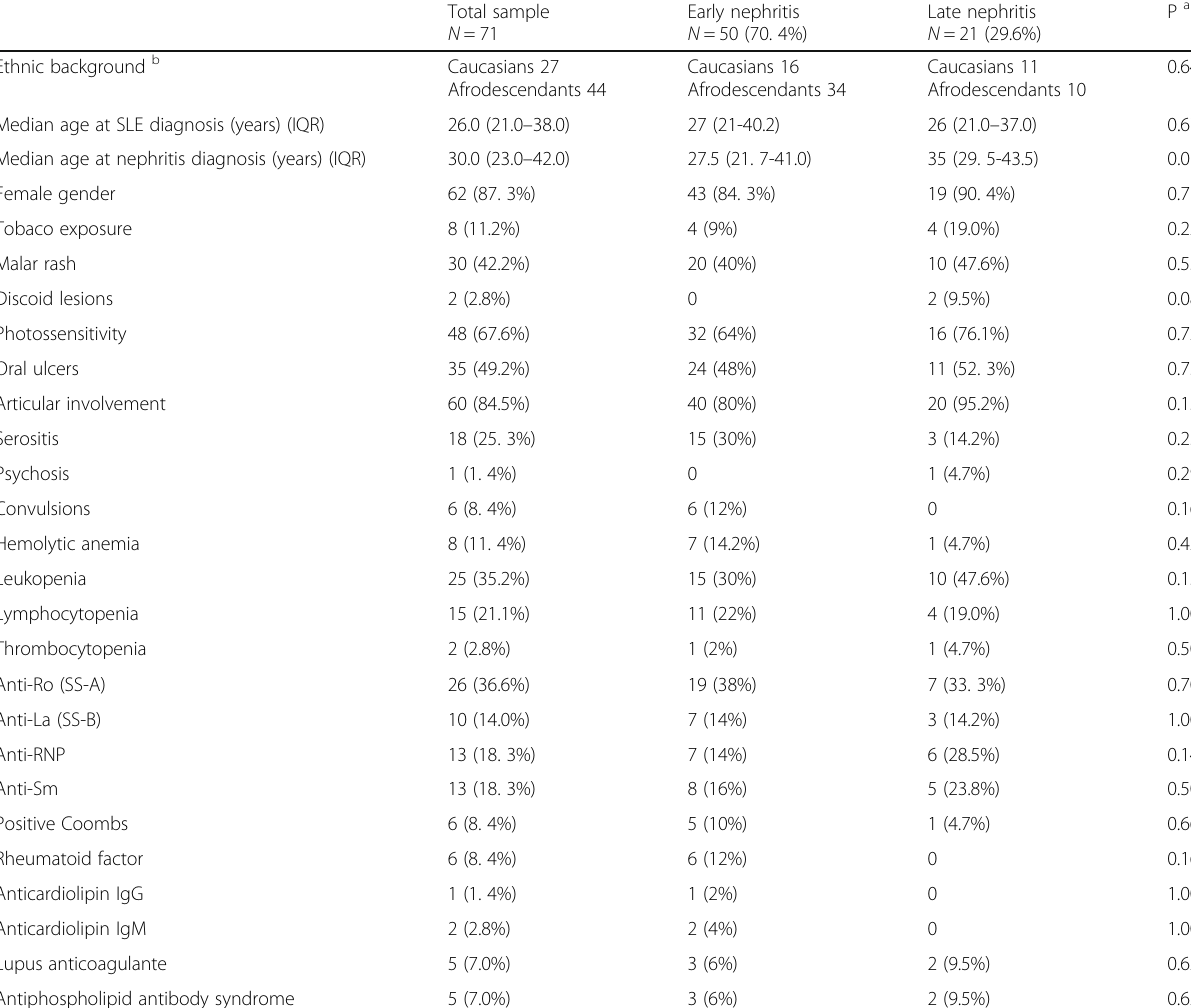
Table 1 Comparative analysis of clinical and serological data in 71 patients with Systemic Lupus Erythematosus (SLE) with early and late onset